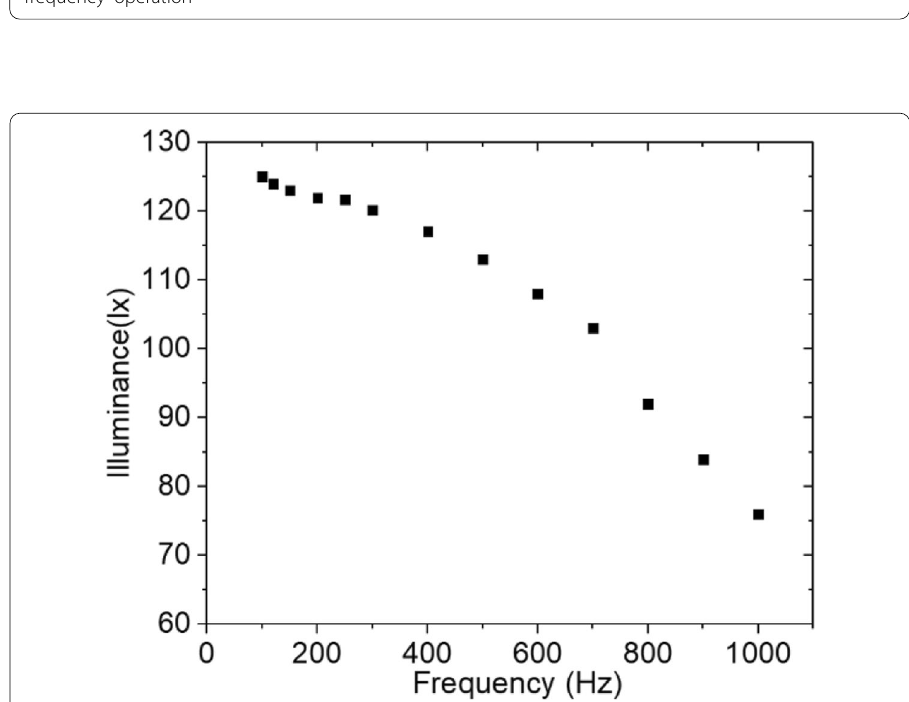
Fig. 6 Illuminance versus frequency of LED device under “constant bias voltage and constant amplification factors”